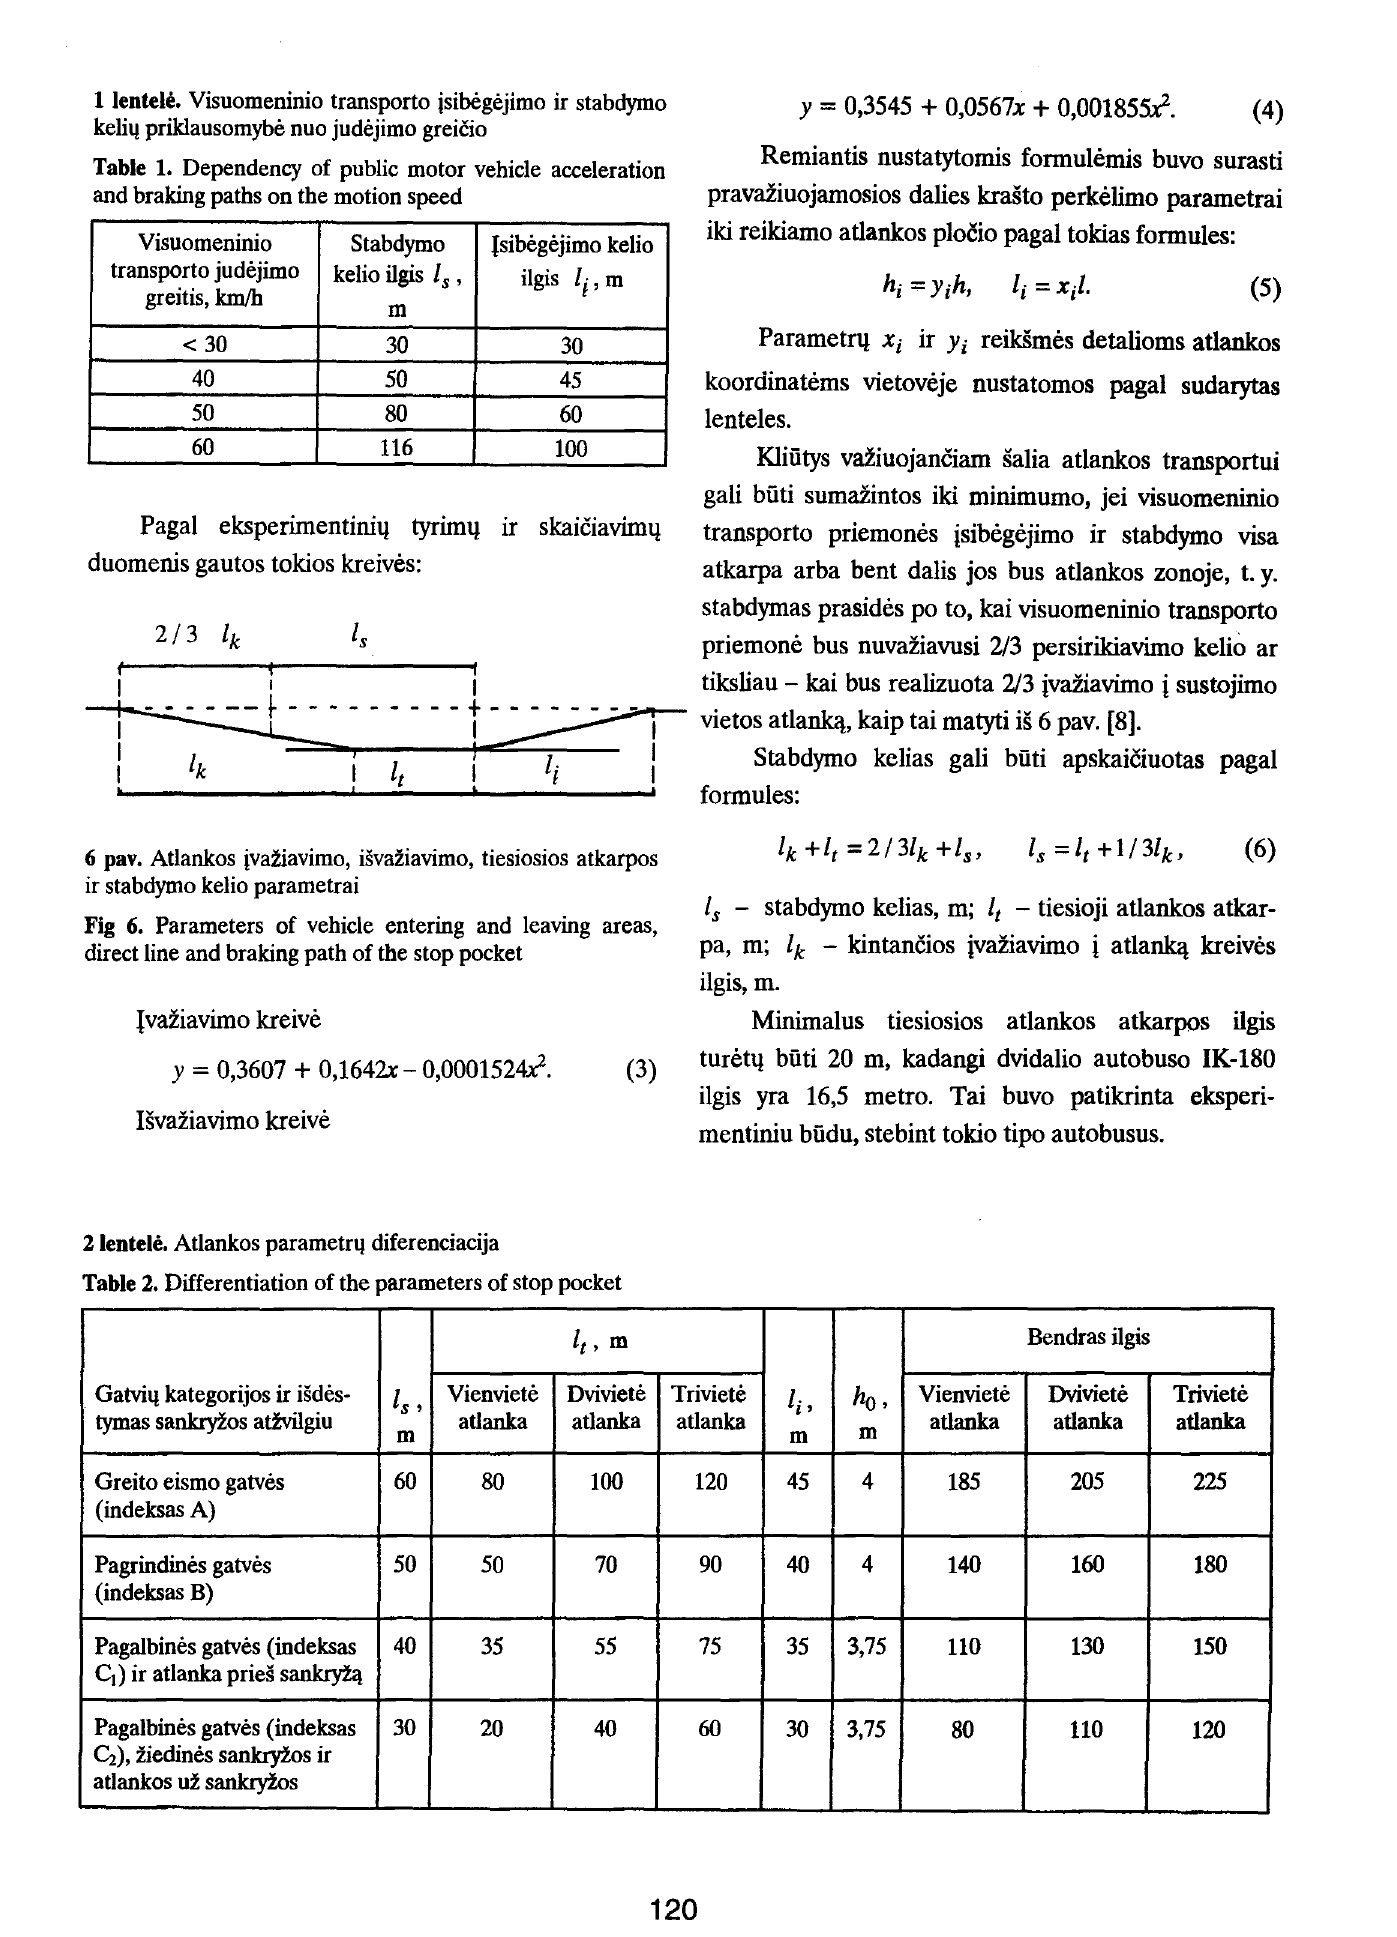
Table 2. Differentiation of the parameters of stop pocket lt, m Bendras ilgis Gatviq kategorijos ir isdes- Is' Vienviete Dviviete Triviete atlanka atlanka